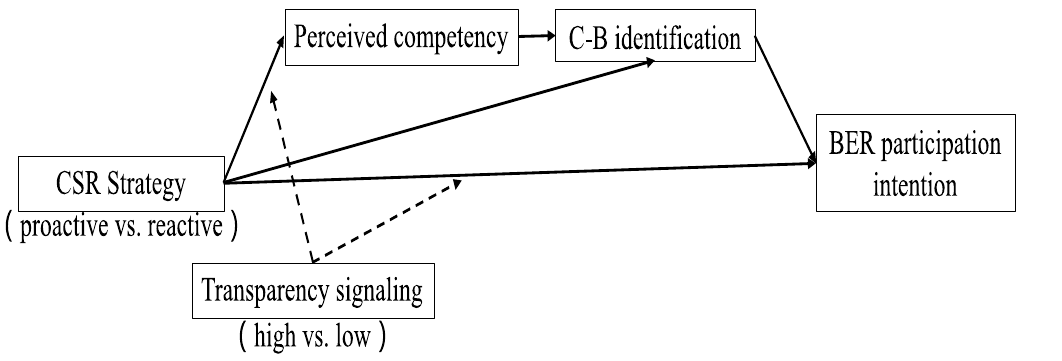
Figure 3. The “CSR strategy × Transparency signaling → perceived competence → CBI → BER participation intention” moderated serial mediation.